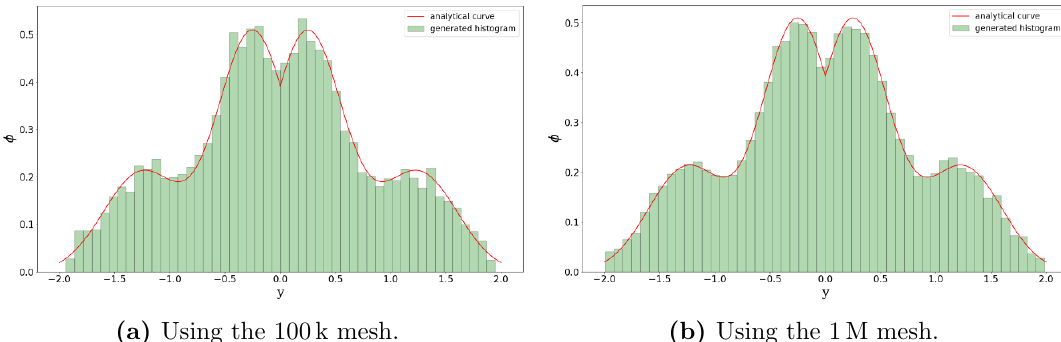
Figure 14. Generation of an unweighted sample according to the 1D pro(cid:12)le function at x = 0. The distribution is normalised to